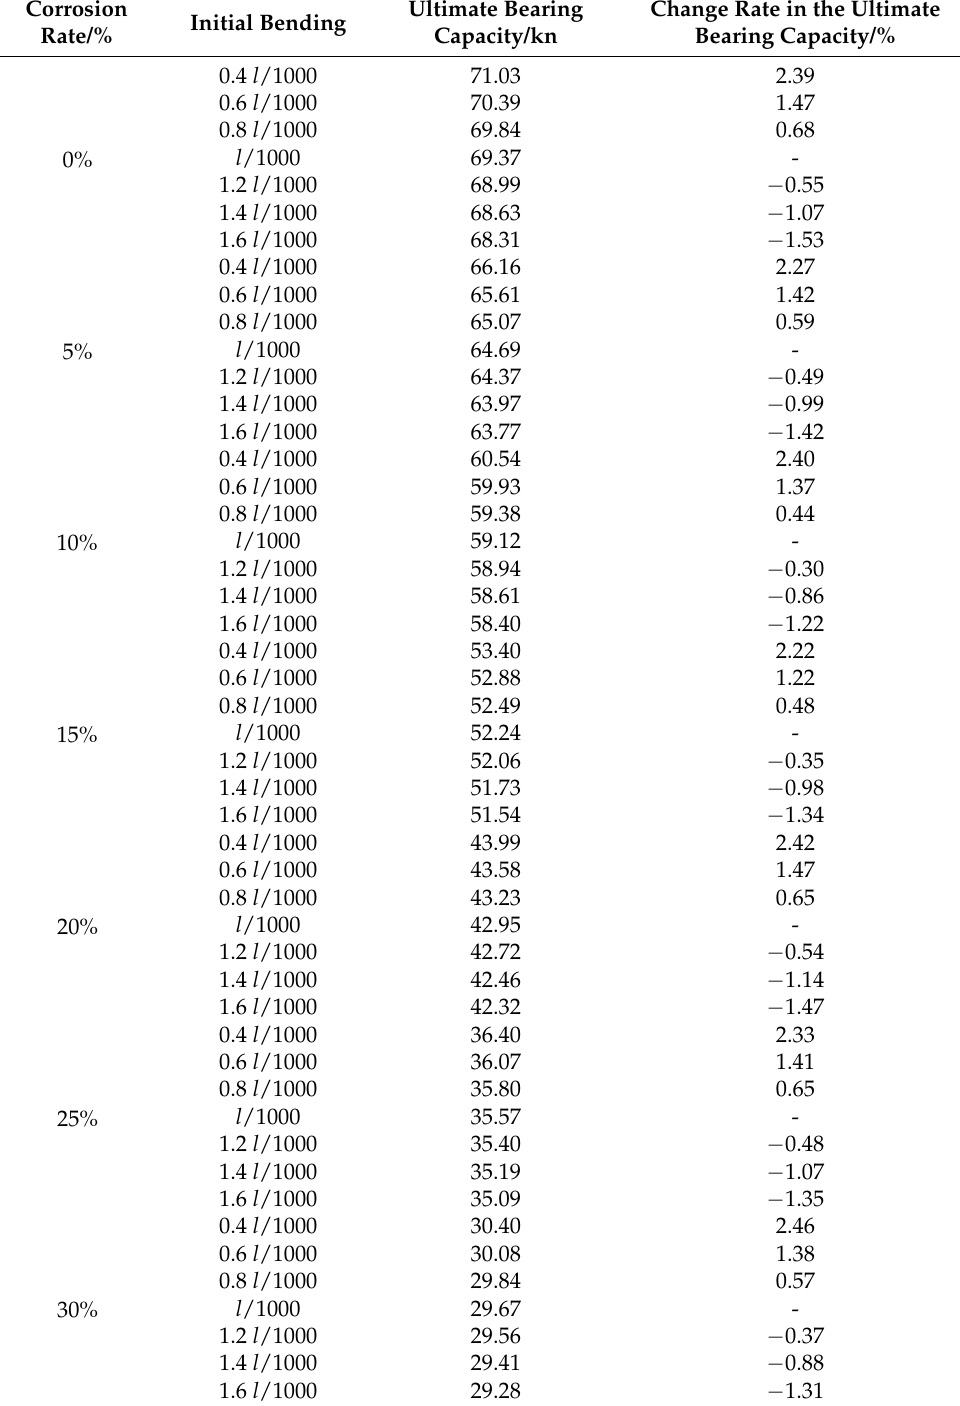
Table 7. Influence of Initial Bending on the Overall Stability Ultimate Bearing Capacity of Steel